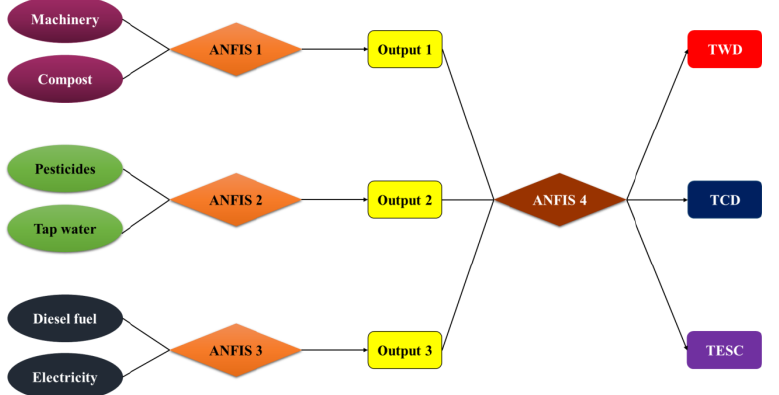
Figure 4. Structure of 2-level ANFIS for predicting TWD, TCD, and TESC of mushroom produc- tion.